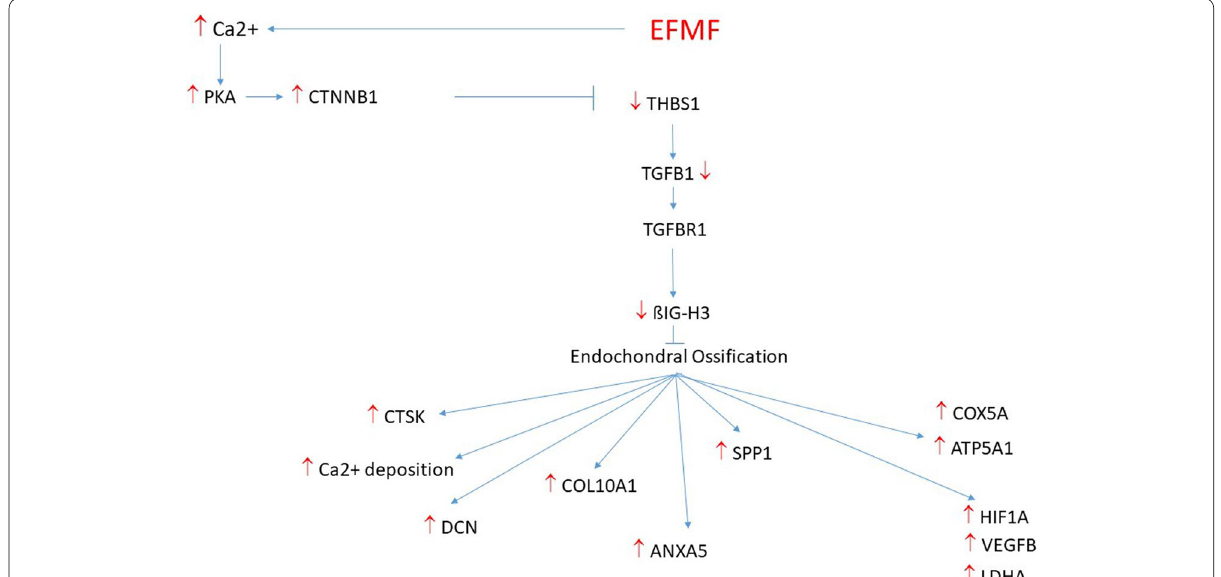
Fig. 6 Suggested signalling pathway for EFMF-induced endochondral ossification. Primary osteoblasts are characterized by high constitutive wnt- and TGFß1- (TGFB1) signaling. The latent TGFB1 converts to its active form under control of trombospondin 1 (THBS1). Active TGFB1 binds to its receptor TGFBR1 and regulates expression of ßIG-H3, which is a negative regulator of endochondral ossification. EFMF exposure increases calcium channel expression and results in Ca 2 + influx. This increased Ca 2 + levels activate protein kinase A (PKA). Activated PKA can phosphorylate catenin beta 1(CTNNB1), which prevents its degradation. The stabilized transcription factor CTNNB1 blocks THBS1-expression and subsequently TGFB1 activation. Reduced TGFB1 activation and EFMF induced reduced TGFB1 expression decreased TGFB1-signalling. This results in reduced expression of the inhibitor ßIG-H3 and stimulation of endochondral ossification. Endochondral ossification linked differentiation is characterized by increased expression of collagen type X (COL10A1), decorin (DCN), annexin A5 (ANXA5), osteopontin (SPP1), cathepsin K (CTSK), hypoxia inducible factor 1 subunit α (HIF1A), vascular entothelial growth factor B (VEGFB), lactate dehydrogenase A (LDHA), cytochrome C oxidase subunit 5A (COX5A), ATP synthase F1 subunit alpha (ATP5A1). and increased Ca-deposition (Fig.